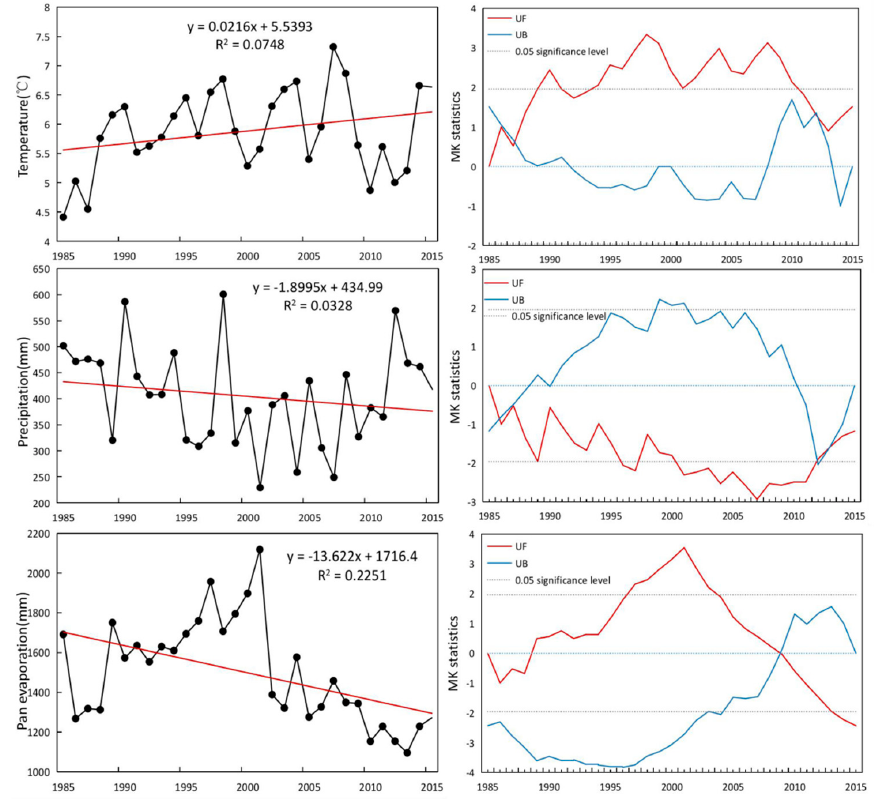
Figure 6. Variation trend and Mann–Kendall test in annual mean temperature, annual precipitation and annual evaporation from 1985 to 2015.